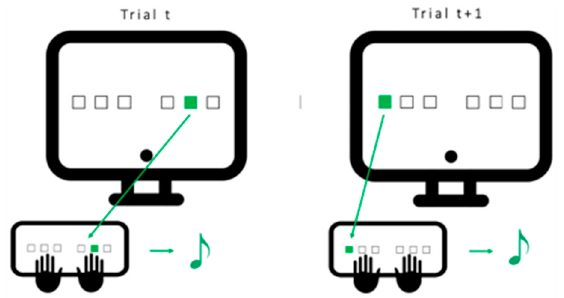
Figure 5. Serial Reaction Time Task (SRTT): Participants are seated in front of the computer with 6 fingers (no pinkies and thumbs) placed on the 6 keys matching the 6 positions on the screen. Each time one of the positions lights up, the participant is instructed to press the matching key as fast and as accurately as possible. Once the key is pressed, an auditory tone matching this key is played and the next cue is presented after 500 msec. One block consists of 96 trials (either sequential or pseudo- random).